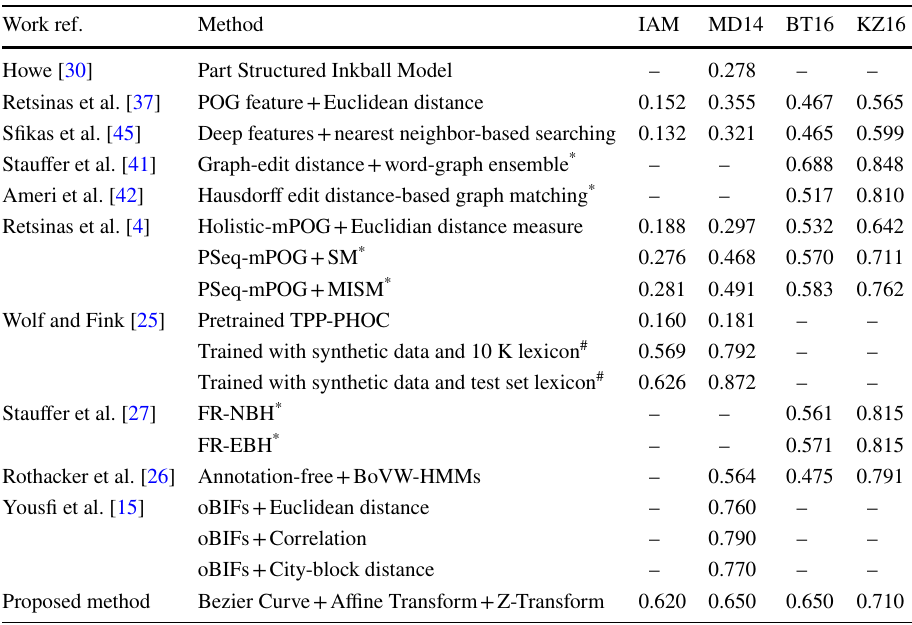
Table 2 Comparison of the proposed method with state- of-the-art methods in terms of MAP